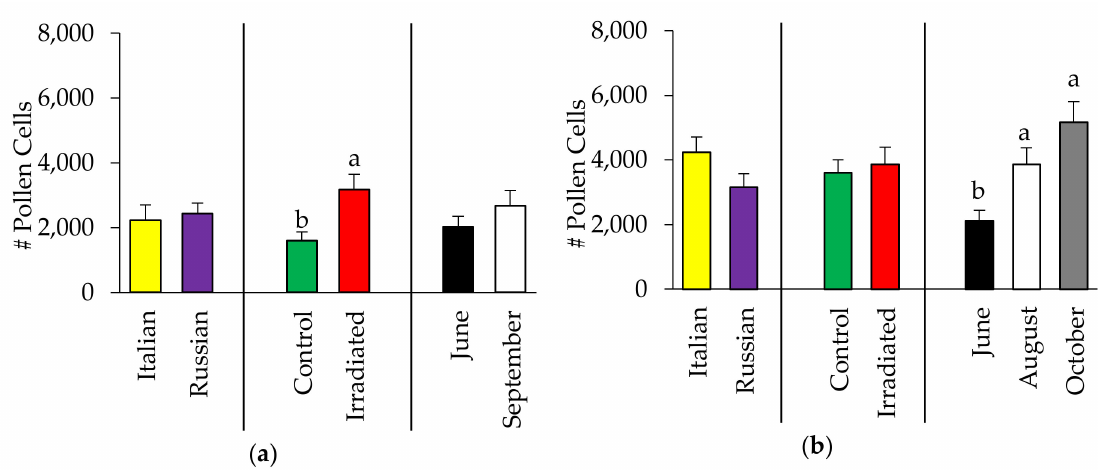
Figure 2. Amount (mean ± SE) of stored pollen in Italian and Russian honey bee colonies having irradiated or non-irradiated (control) combs in ( a ) 2015 and ( b ) 2016. For each group, bars with the same letters are not significantly different ( p > 0.05); without letters indicates no differences.